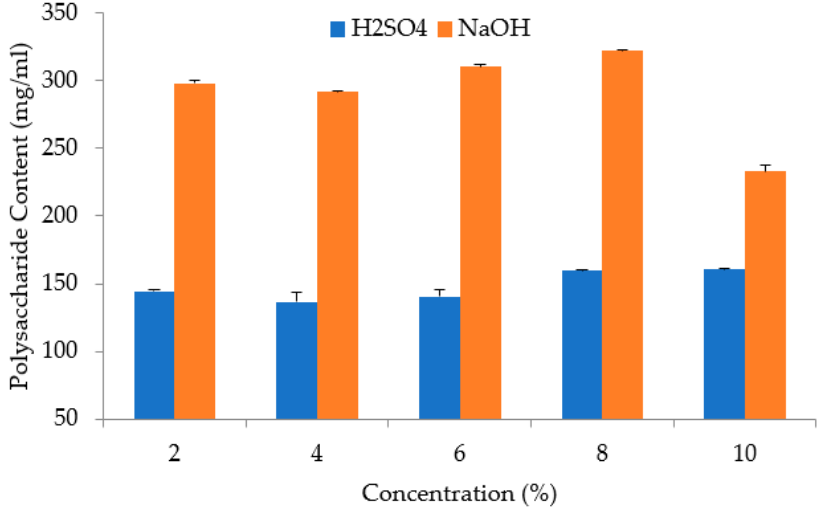
Figure 1. Polysaccharide extraction using H 2 SO 4 and NaOH at different concentrations.